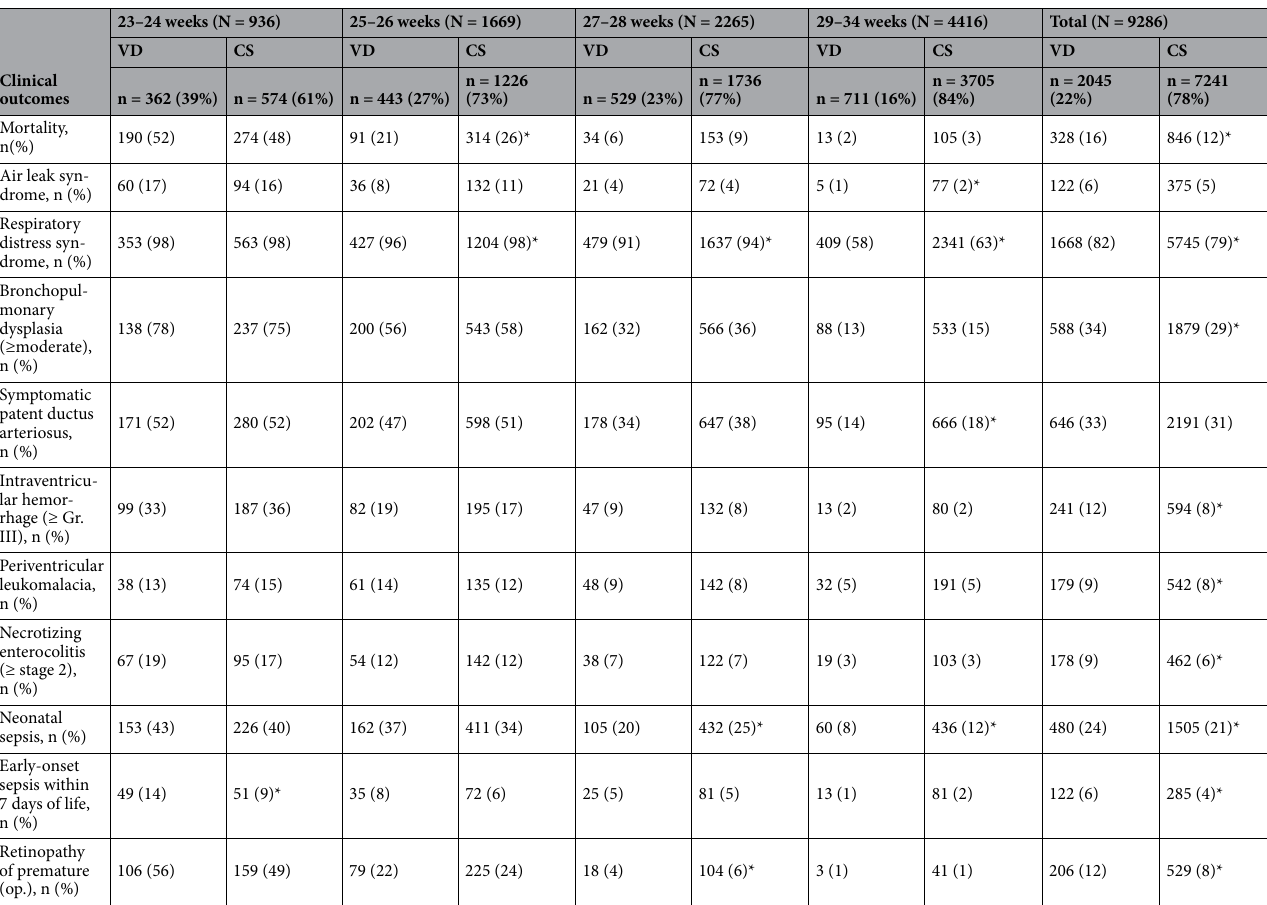
Table 2. Comparison of mortality and morbidities in the study population. VD vaginal delivery, CS Cesarean section, op operation. *p < 0.05 compared with